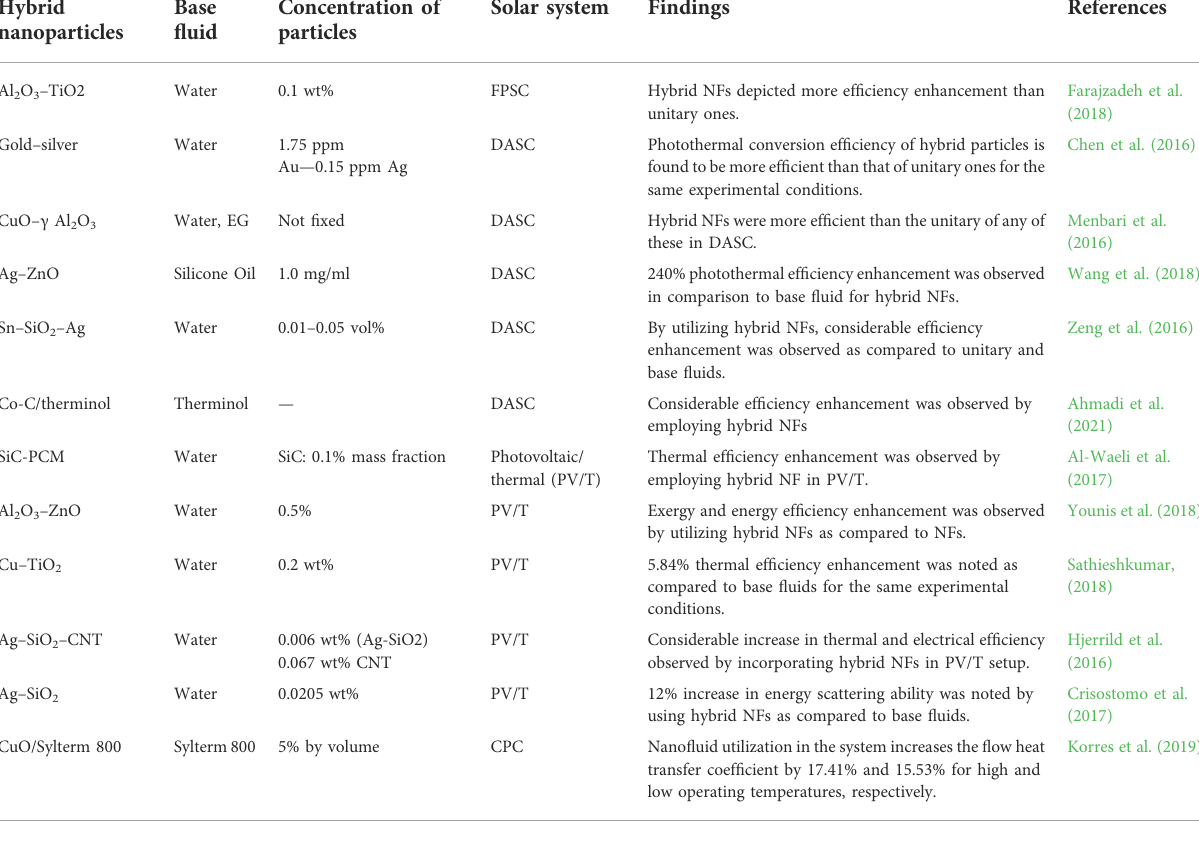
TABLE 1 Summary of various investigators on various hybrid NFs in different applications.